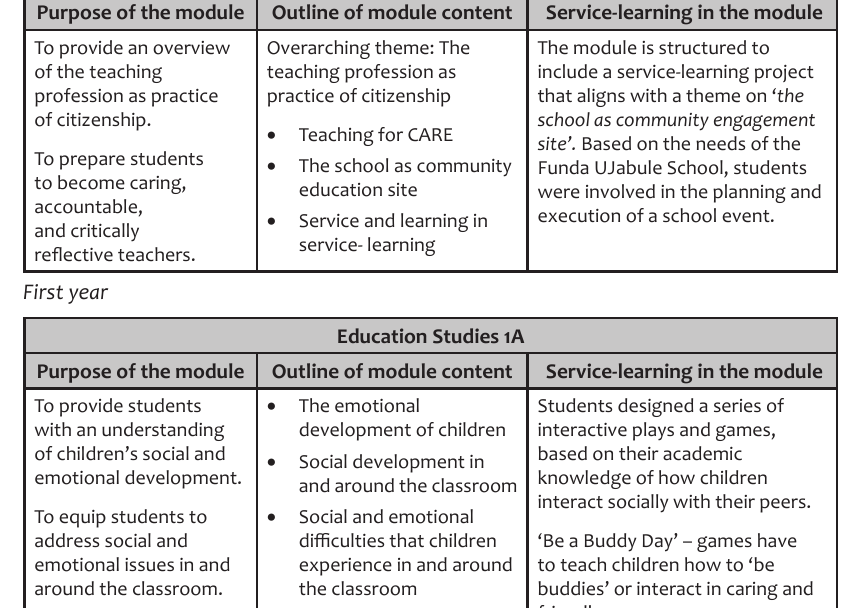
Table 1: Service-learning in curriculum modules over four years First year Teaching Studies 1A Outline of module content Service-learning in the